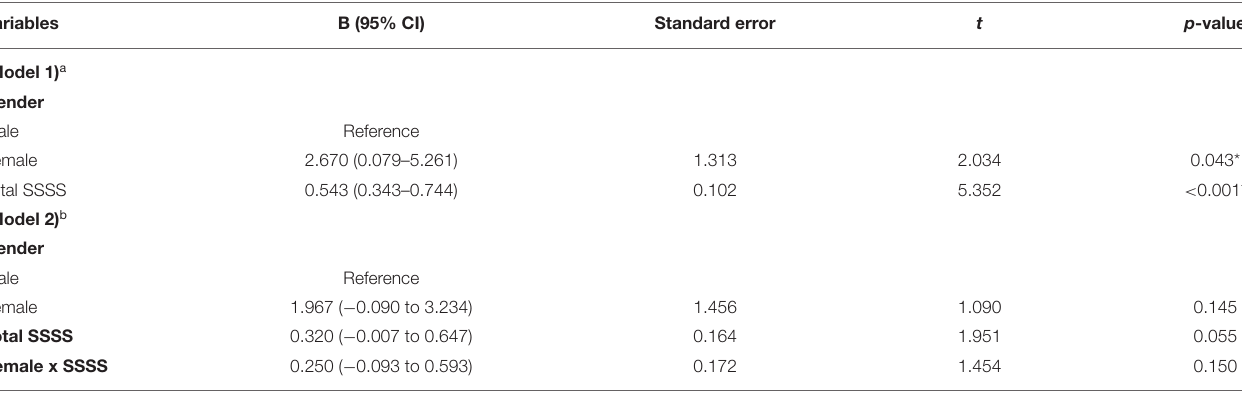
TABLE 5 | The moderating effect of gender on the association between the total SSSS score and total PTGI-SF score. Variables